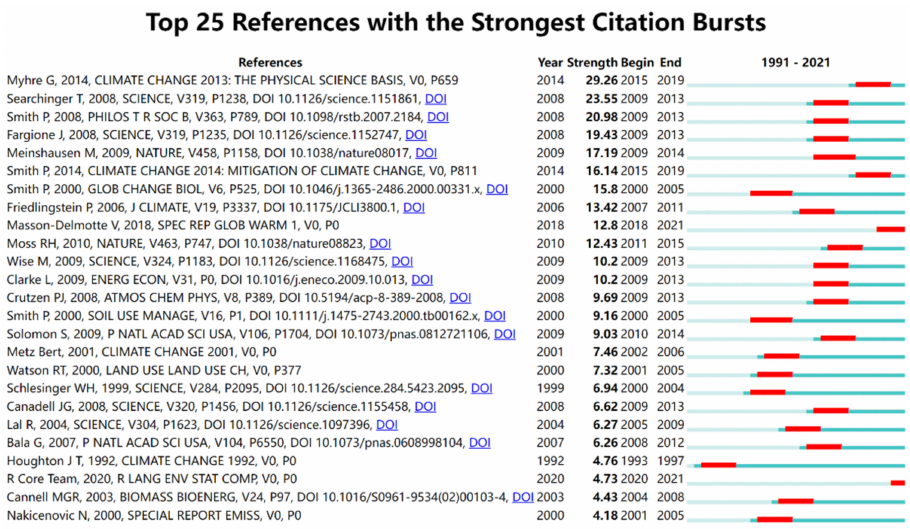
Figure 6. Top 25 Cited Studies on Carbon Emission Reduction Research. Note: the top 25